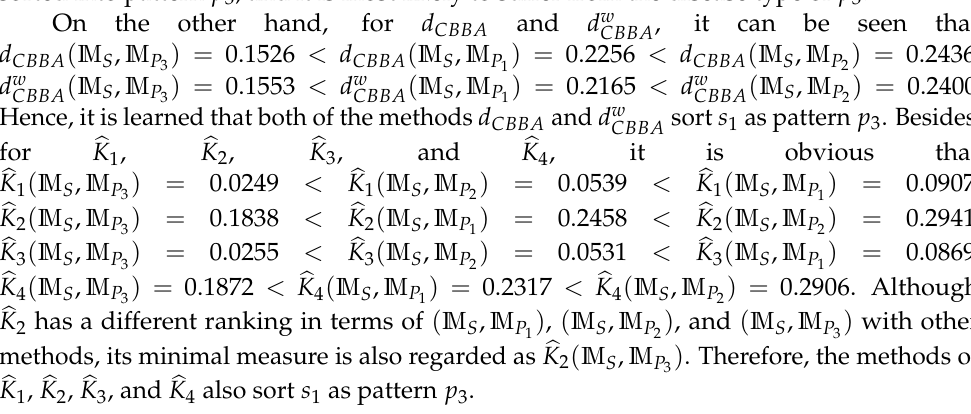
Table 6. The ranking and sorting obtained through different methods in the application. Methods